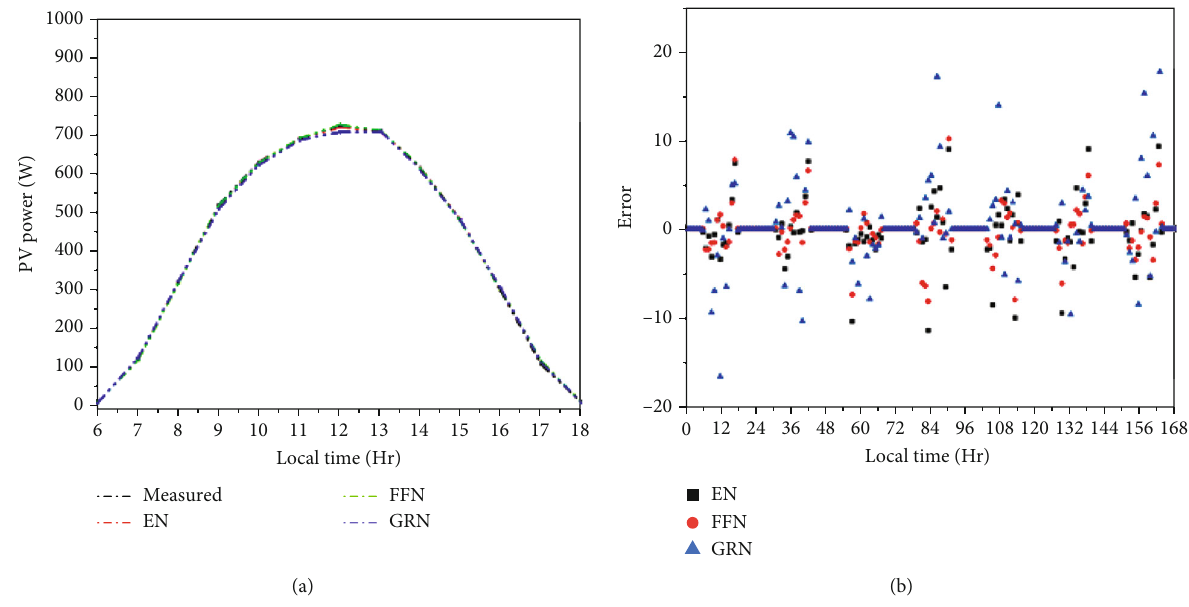
Figure 10: Hourly variation of the BISTPV system. (a) DC output power of EN, FFN, and GRN. (b) Error of the EN, FFN, and GRN.